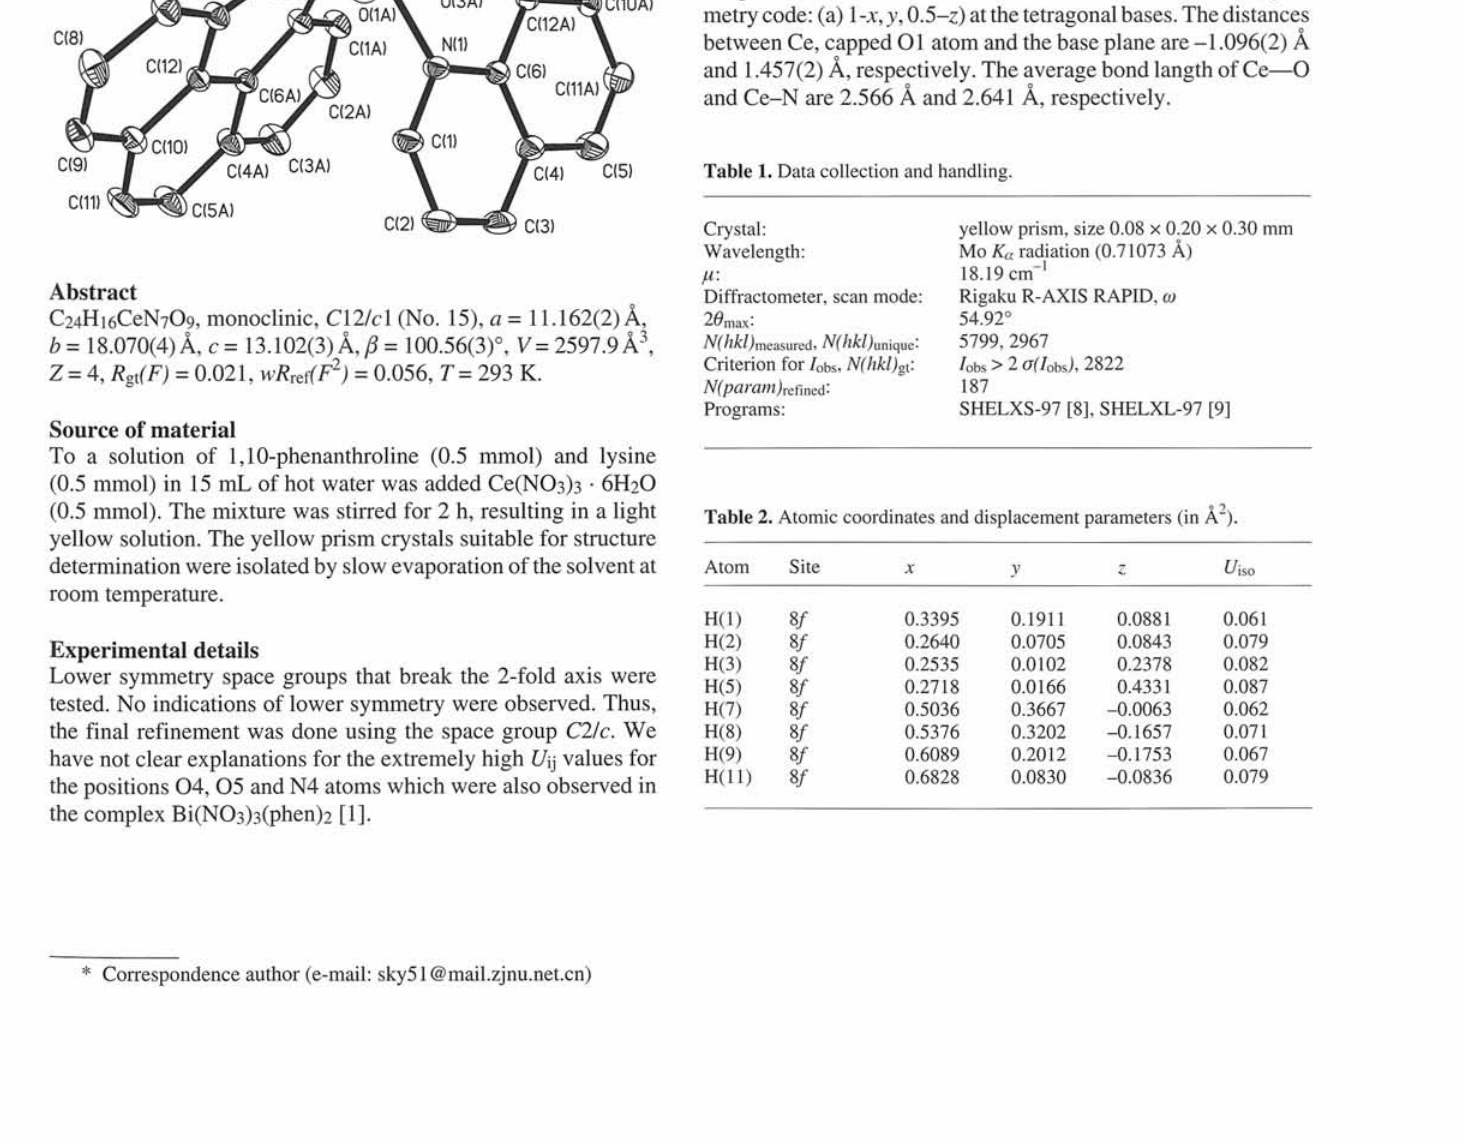
Table 1. Data collection and handling.